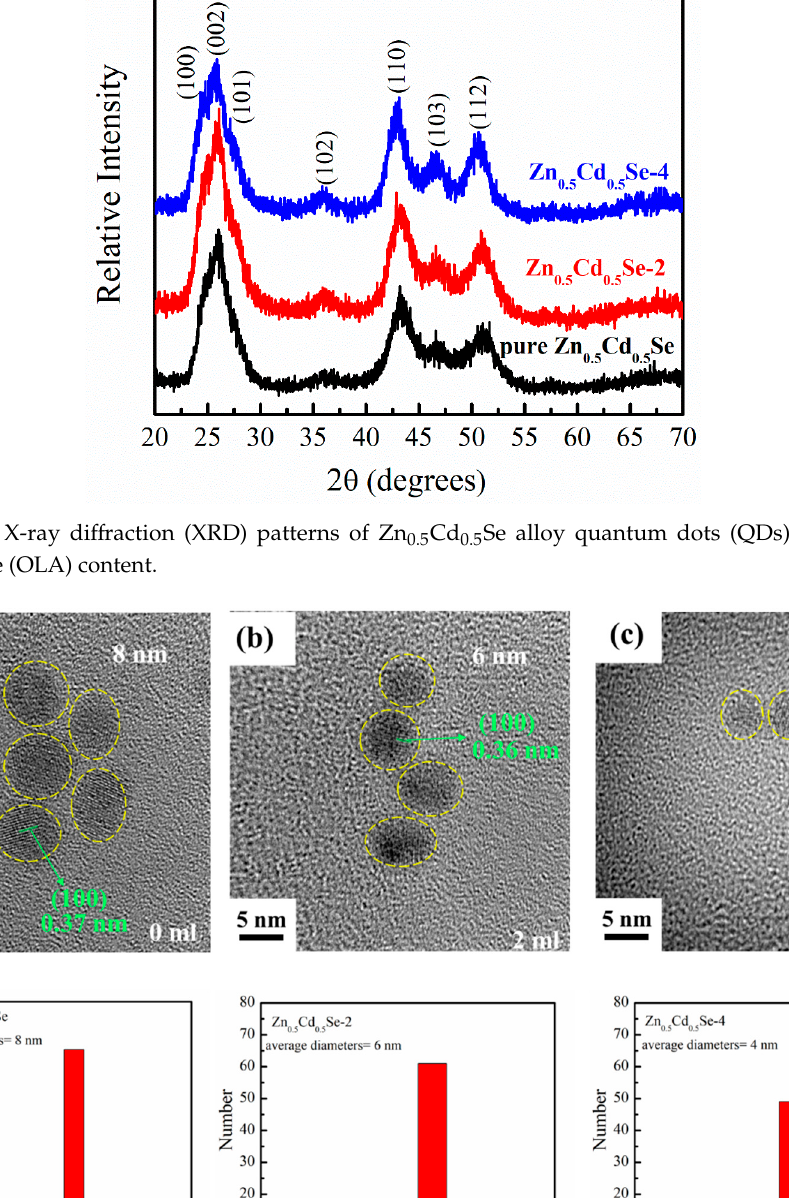
Figure 2. High-resolution transmission electron microscopy (HRTEM) images and size distributions showing the influence of low OLA content on ( a ) pure Zn 0.5 Cd 0.5 Se, ( b ) Zn 0.5 Cd 0.5 Se-2, and ( c ) Zn 0.5 Cd 0.5 Se-4 alloy QDs.